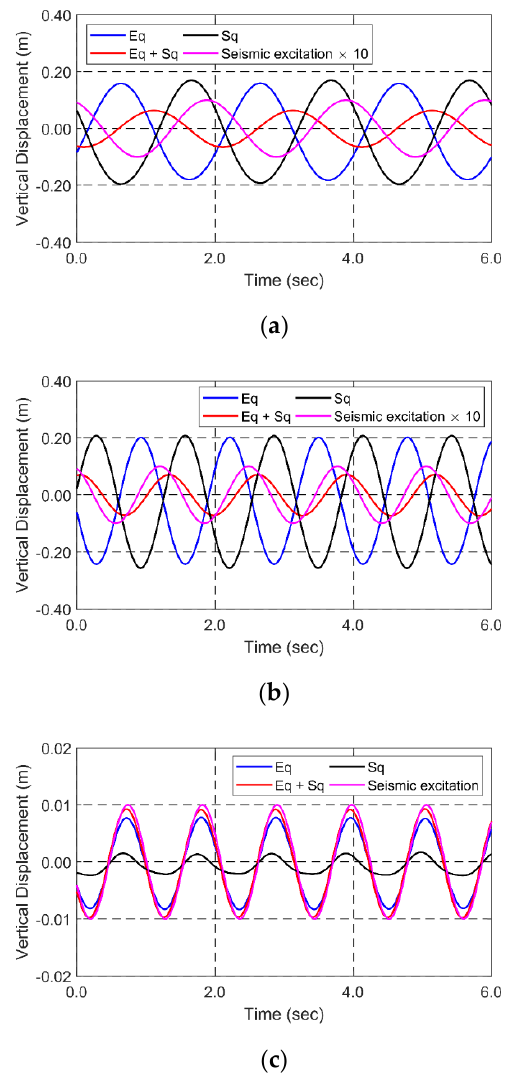
Figure 11. Time histories of vertical displacements of the tunnel at the middle section by respective force components under regular seismic excitations of 3.12 rad/s ( a ), 4.89 rad/s ( b ), and 5.78 rad/s ( c ) (Eq: earthquake only considered; Eq + Sq: both earthquake and seaquake considered; Sq: seaquake only considered; time histories of seismic excitations are multiplied by 10 for better visualization).